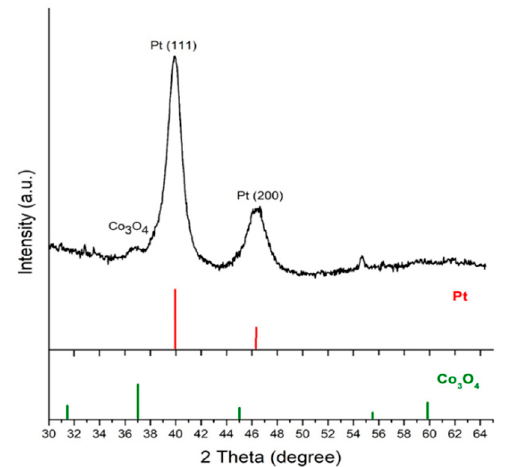
Figure 5. The XRD pattern of Co 3 O 4 @Pt / GN as well as JCPDS of cubic Co 3 O 4 (JCPDS: 073–1701) and fcc Pt (JCPDS: 1–87–636).